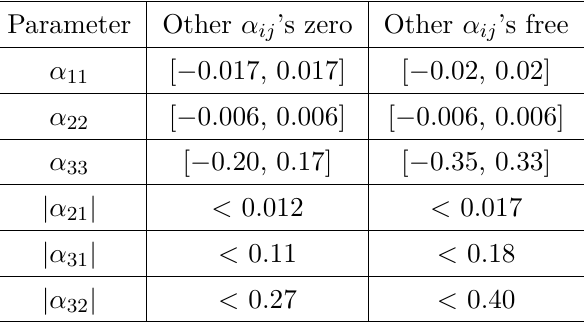
Table 11 . 90% C.L.(1 d.o.f.) limits on various NUNM parameters. Second column shows the constraints considering only one NUNM parameter at a time, while other NUNM parameters are assumed to be zero in the fit. Third column depicts the bounds on a given NUNM parameter when all other NUNM parameters and the phases associated with the off-diagonal parameters are kept free in the fit. True values of the standard oscillation parameters are taken from table 2. We marginalize over θ and δ in the fit (see text for 23 CP